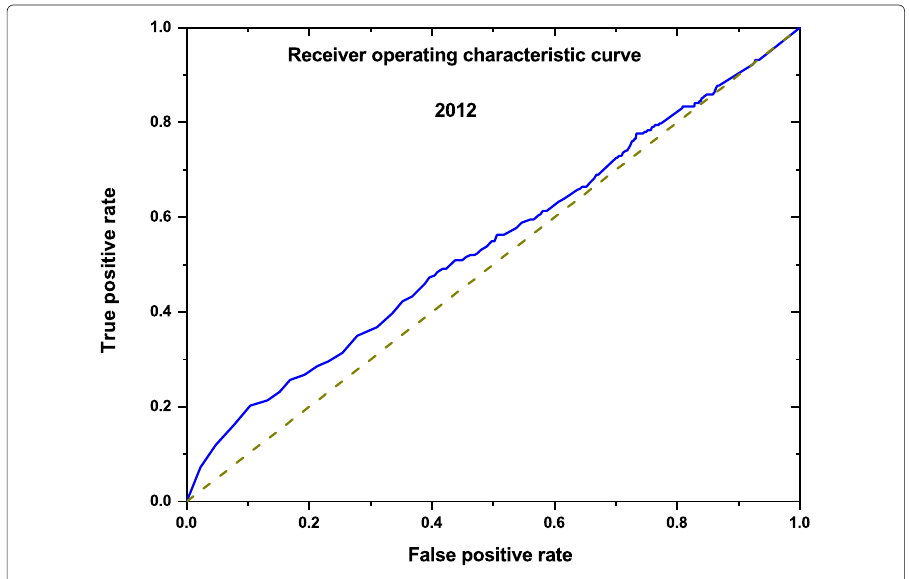
Fig. 6 The receiver operating characteristic curve (ROC) using the k-shell method for predicting the disappeared firms in the 2012